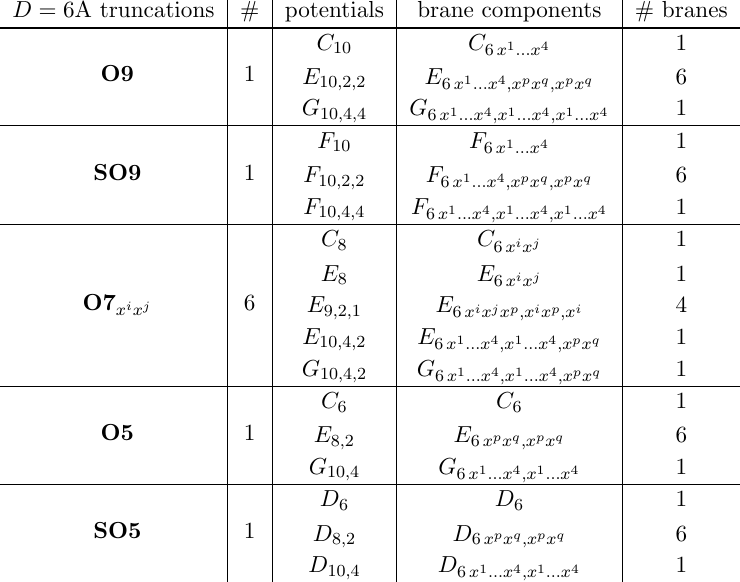
Table 6 . The Z 2 truncations of the maximal theory in D = 6 leading to the N = (1 ; 1)